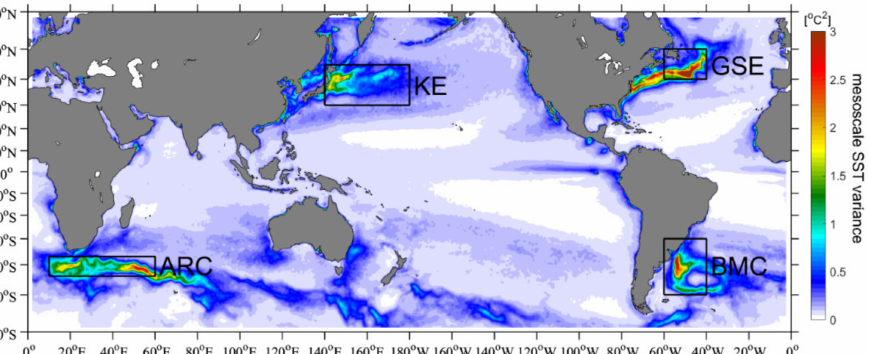
Figure 1. Mean mesoscale SST variance distribution derived from OI.v2-AVHRR-only data during 1993–2018. The black boxes denote the Kuroshio Extension (KE, 140 ◦ E–180 ◦ E, 30 ◦ N–45 ◦ N), the